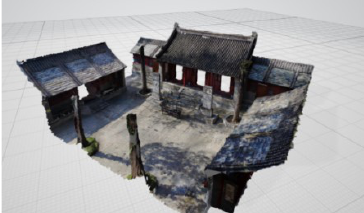
Figure 4: Application of 3D Laser scanning Technology